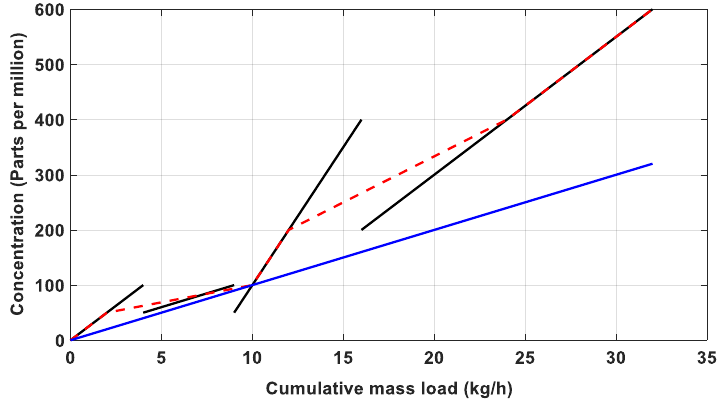
Figure 3. The resulted curve from Kuo and Smith data using the analyzed algorithm Data of Mohammadnejad research